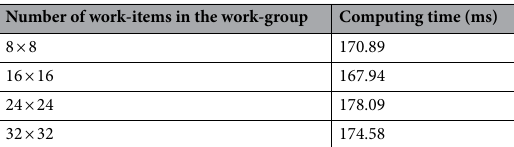
Number of work-items in the